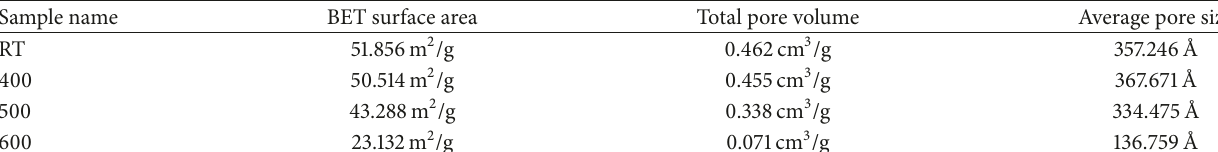
Table 1: The surface area, pore volume, and pore size of Fe doped TiO 2 at different annealing temperature.